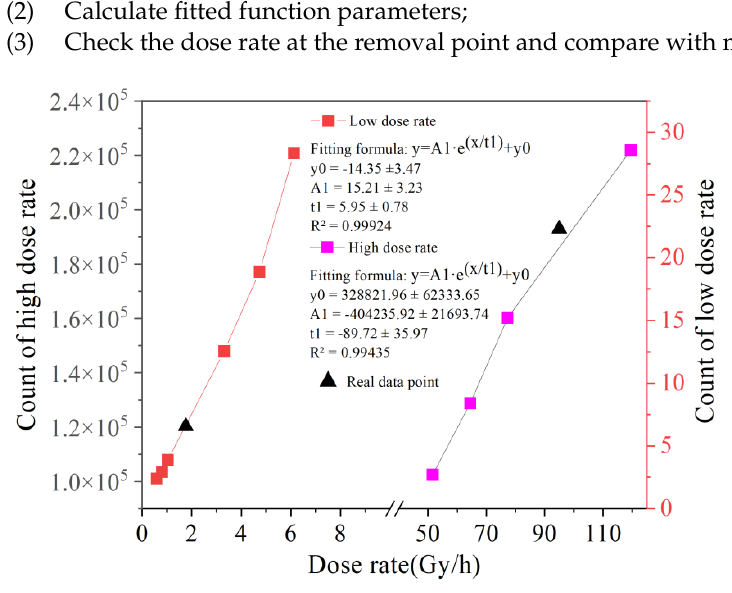
Figure 8. Calibration eigenvalue response curve.